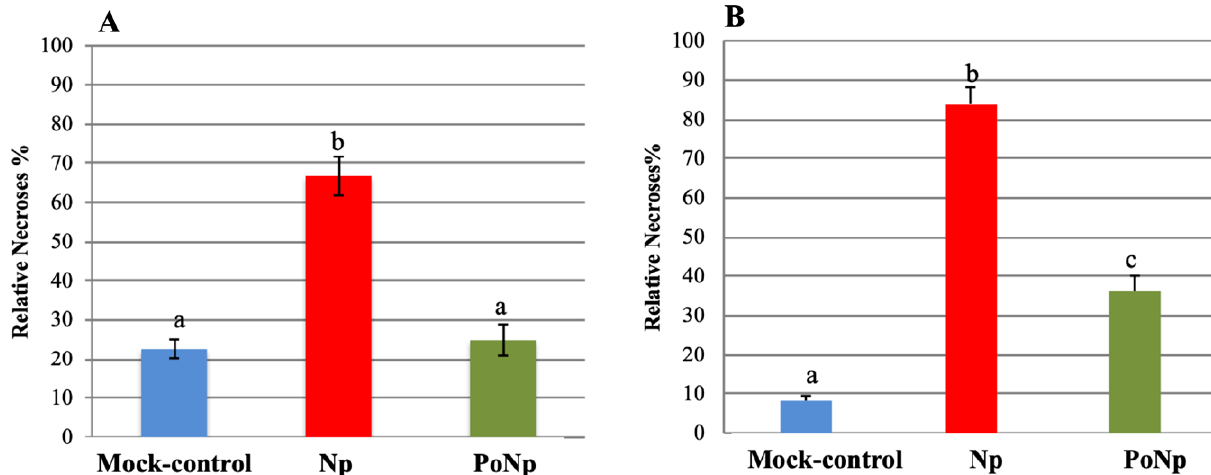
Figure 2. Wood necrosis resulting from inoculations with Neofusicoccum parvum in trunk cuttings with or without inoculation with P. oli- gandrum (Po) at root level, 150 days post-inoculation. The values reported are means (± SE) of 30 samples collected from each treatment. PoNp = Po + N. parvum , and Np = N. parvum . Different letters indicate differences ( P > 0.05) between